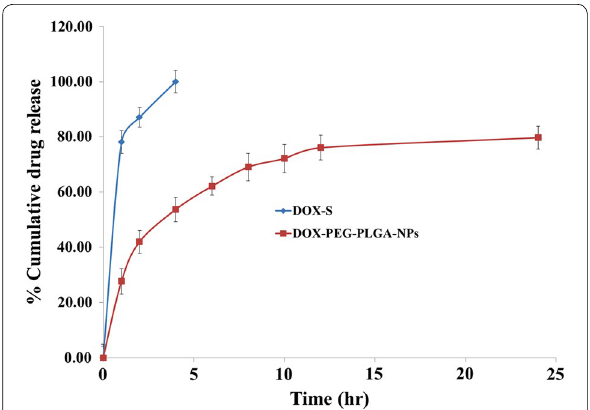
Fig. 3 In vitro release profile of DOX-Solution and DOX-loaded- PEG-PLGA-NPs performed by using dialysis bag method, revealing sustained release pattern of DOX-loaded-PEG-PLGA-NPs (mean n =